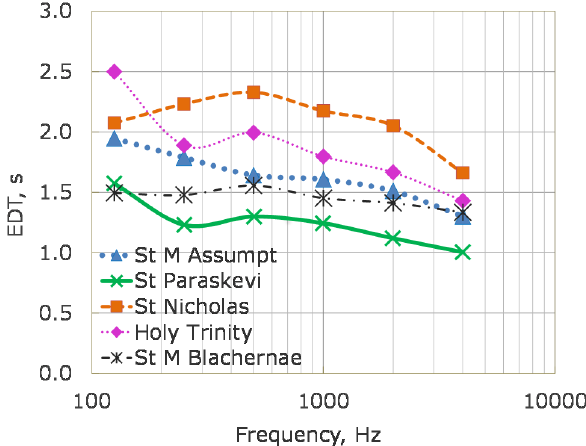
Figure 13. Measured results of early decay time (EDT).